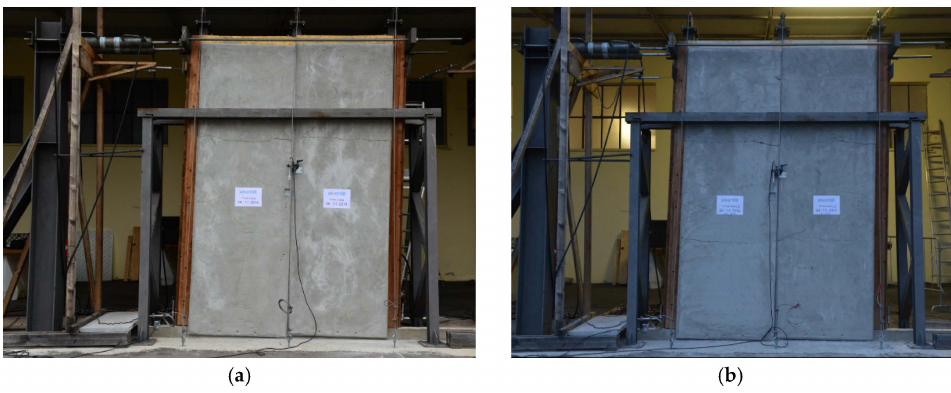
Figure 10. Wall configurations at the end of the cyclic loading tests: ( a ) Wall A and ( b ) Wall